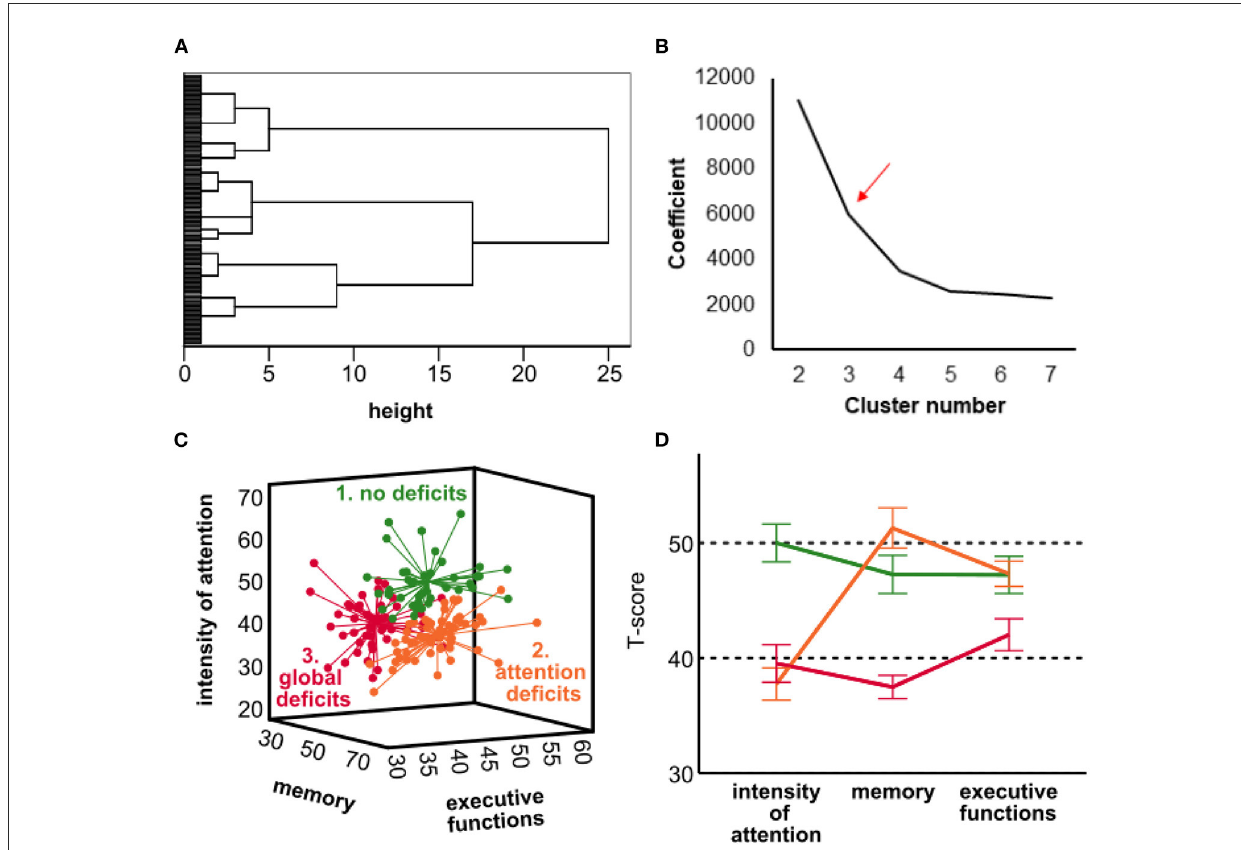
FIGURE1 Visualization of cognitive clustering. (A) Dendrogram for hierarchical representation of clusters. Each leaf represents an individual observation. Leaves are spaced evenly along the vertical axis. The horizontal axis indicates a distance or dissimilarity measure. The height of a node represents the distance between the two clusters. The graph is used to visualize how clusters are formed. The number of clusters that seemed to have an optimal dissimilarity measure within each cluster was set at three. (B) Scree plot derived from hierarchical cluster analysis. The y -axis represents the degree of homogeneity within the cluster, while the x -axis shows the number of clusters. The optimal number was set at the bend of the curve, which also was at three clusters confirming visual determination by our dendrogram. (C) Three-dimensional visualization and line diagram of cognitive clusters as generated by subsequent k-means cluster analysis. Each point represents an HF patient. Lines represent the central trend of the cases in terms of their cognition. (D) T-scores of the cognitive domains are given. Dots represent a single patient; centroid projection was applied. Whiskers display mean and 95% confidence